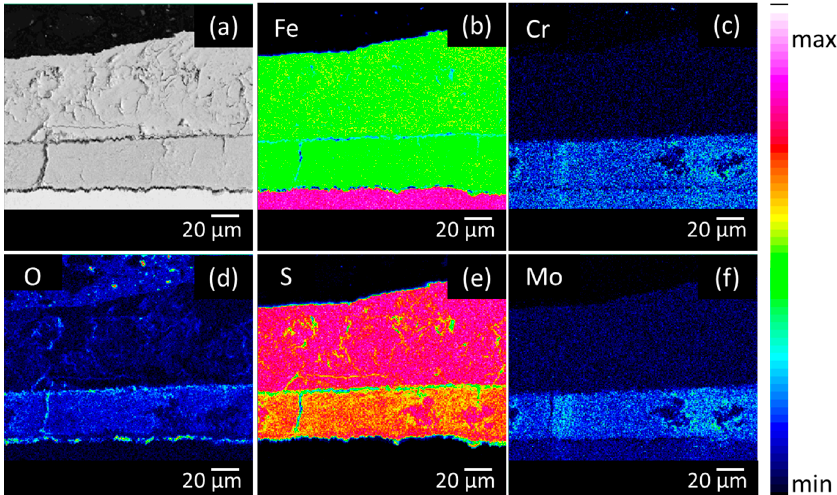
Figure 6. Cross-sectional BSE image ( a ) and elemental mappings of ( b ) Fe, ( c ) Cr, ( d ) O, ( e ) S and ( f ) Mo of the high Mo material after 28 days of immersion in the H 2 S saturated test solution.